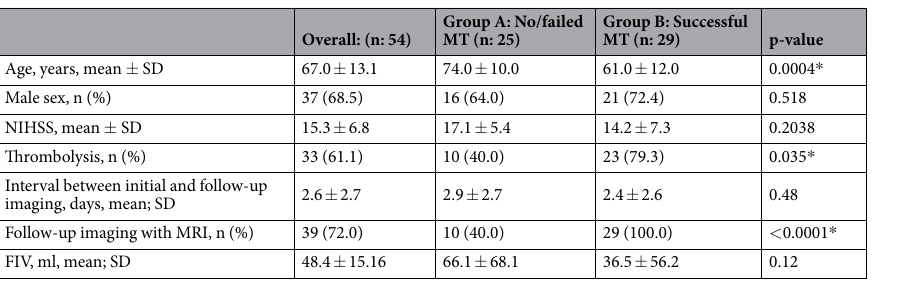
Table 3. Characteristics of both groups with Wilcoxon test being used for comparison of differences, * indicating statistical significance (p < 0.05). MT = mechanical thrombectomy. SD = standard deviation. NIHSS = National Institutes of Health Stroke Scale. FIV = final infarct volume.